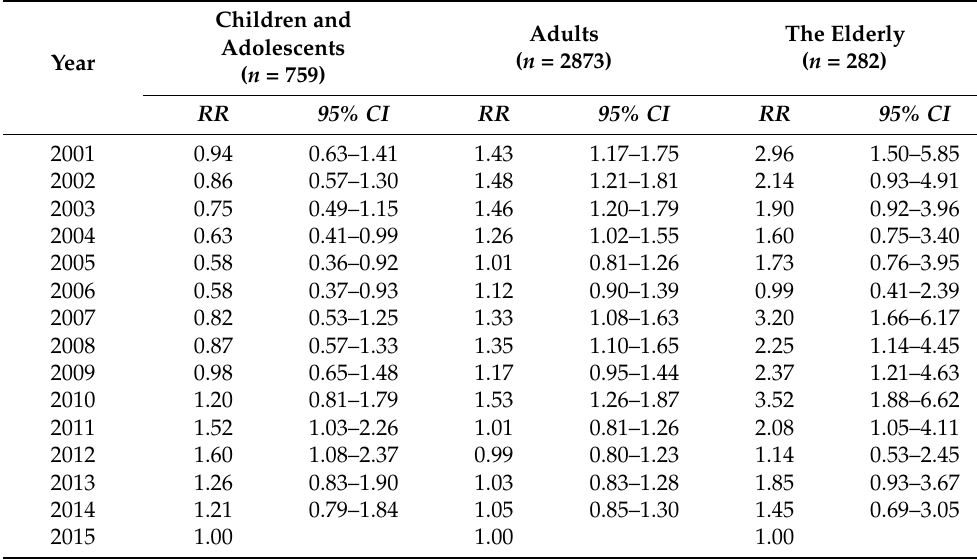
Table 5. Relative hazard ratio (RR) of Children and Adolescents, Adults, and The Elderly who were subjected to violence to seek medical treatment over the years